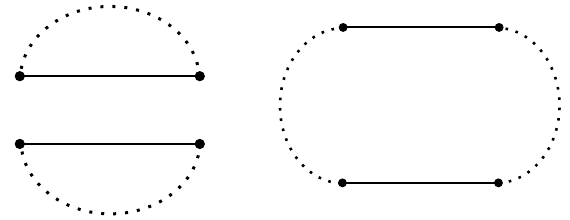
Figure 9 . Graphical representation of the interaction vertices of the GN model, displaying the two types of spinor indices contraction (dotted lines): the usual disconnected contraction (left) and the connected one